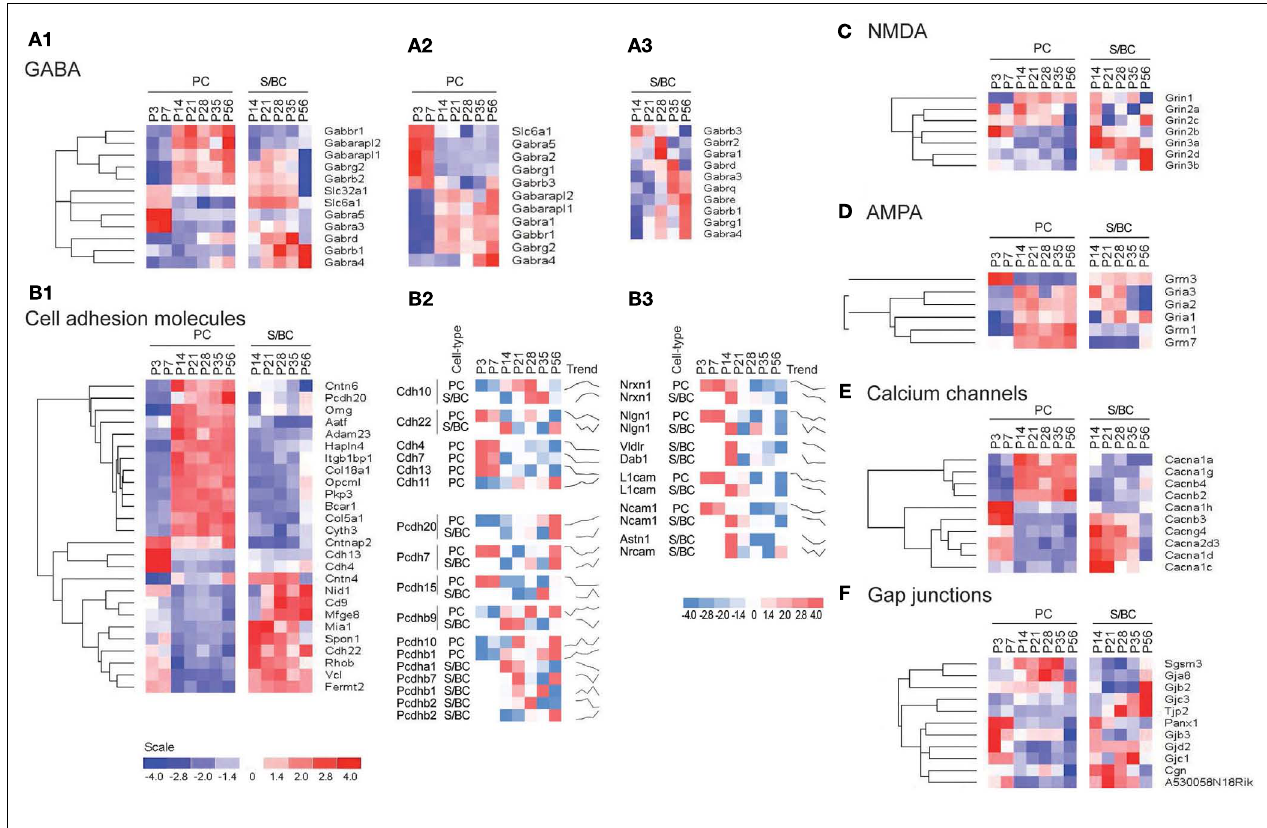
molecules (CAMs) transcripts, (B2,B3) PC and SB specific individual profiles are shown. (C) Cell-type specific expression of NMDA receptors, (D) AMPA receptors, (E) Calcium channels, and (F) Gap junction